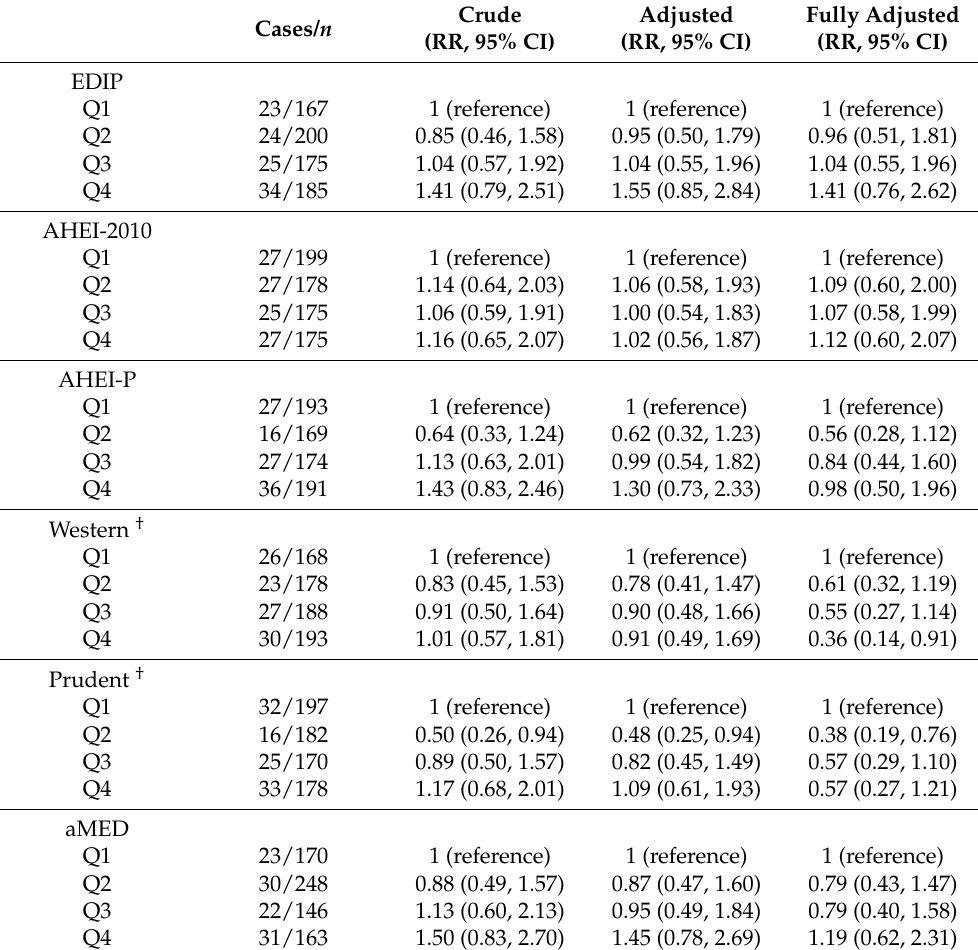
Table 4. Association between maternal dietary patterns and child autism spectrum disorder diagnosis in NHSII ( n =